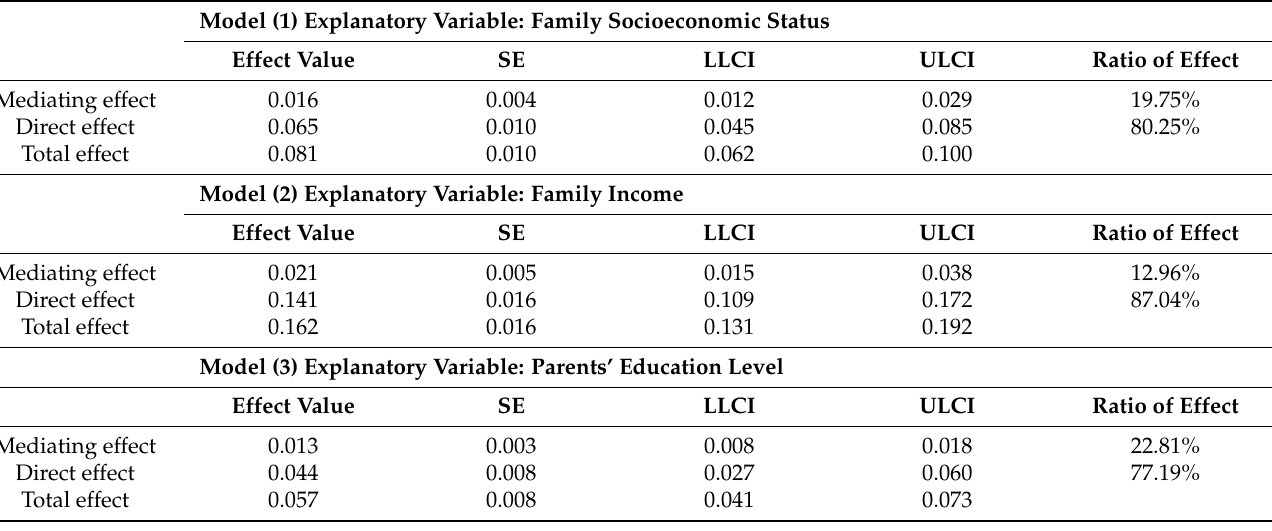
Table 9. Mediating Effect Test Table of Social